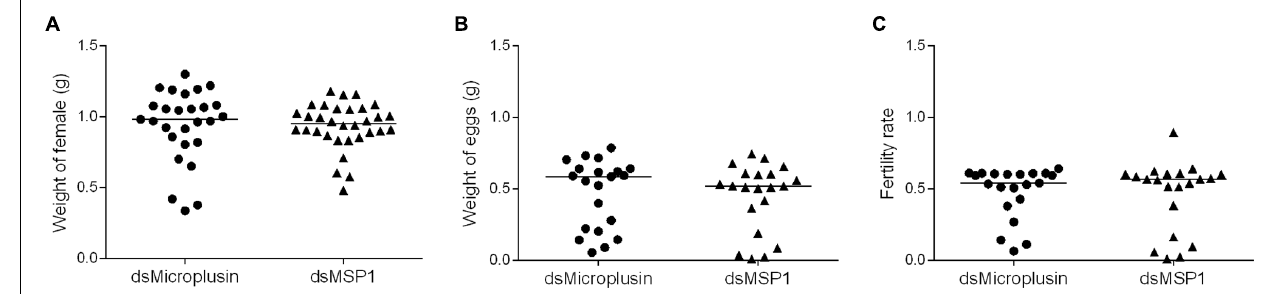
FIGURE 6 | Effects of RNAi-mediated silencing of microplusin on tick fitness. Specific dsRNA for either microplusin (dsMicroplusin) or MSP1 (dsMSP1; control) were injected into the hemocoel of non-infected ticks. After 24 h, ticks were fed on one non-infected dog. The weight of engorged ticks (A) , weight of the egg mass (B) , and fertility rate (C) were